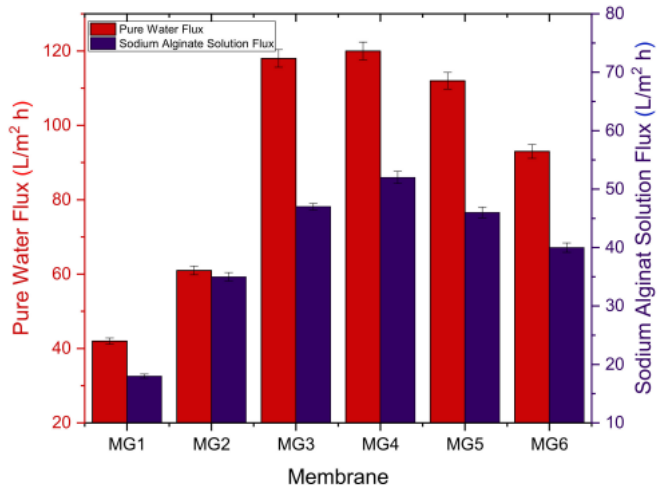
Figure 17. Pure water and NaAlg solute alginate solution flux of synthesized membranes, diagram taken from [151].